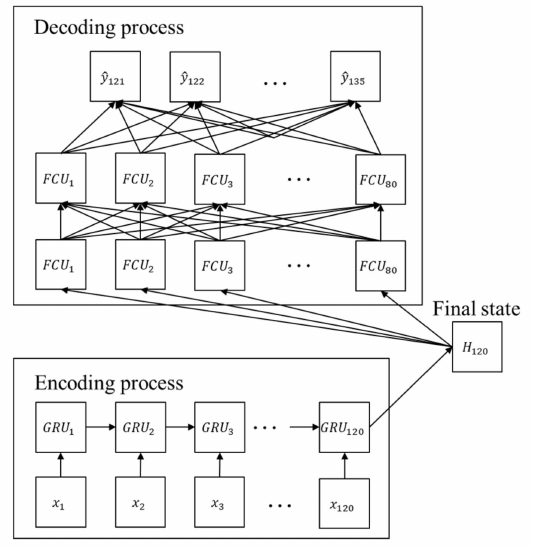
Figure 4. Illustration of the encoding and decoding processes used to make the